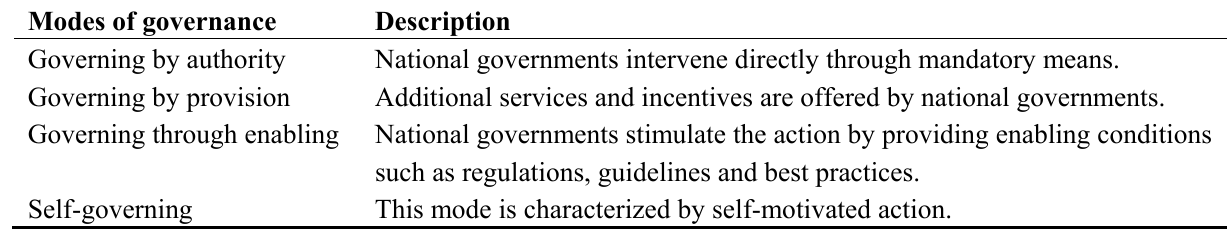
Table 2. Modes of